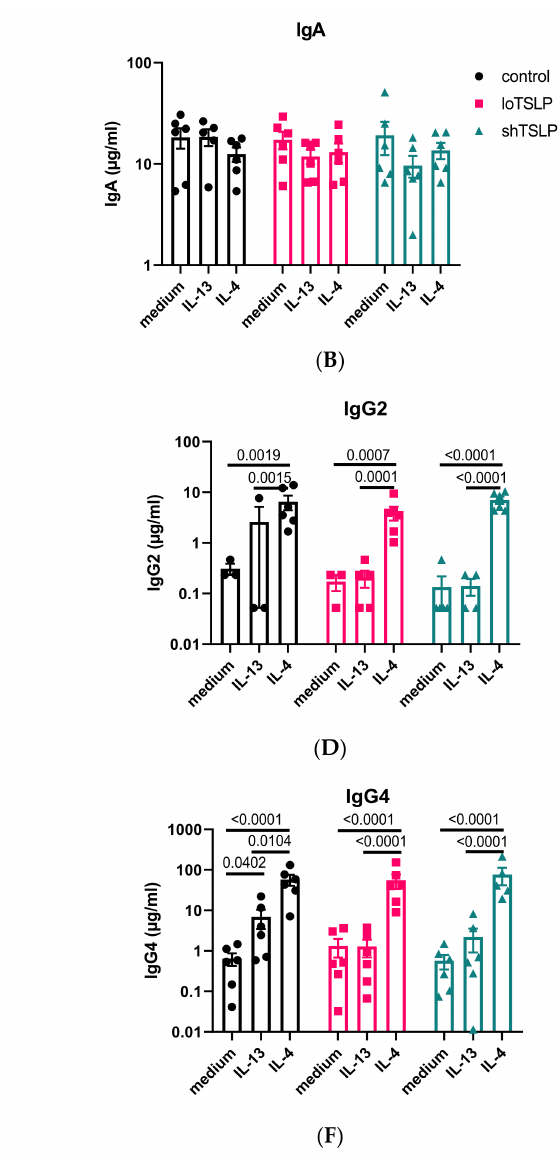
Figure 2. Regulation of Ig secretion by IL-4, IL-13, and TSLP. The concentrations of IgM ( A ), IgA ( B ), IgG1 ( C ), IgG2 ( D ), IgG3 ( E ), and IgG4 ( F ) in B cell culture supernatants after 11 days of stimulation using the T cell-dependent protocol using irradiated CD40L expressing cells. Mean concentrations and standard error of the mean are shown. Statistical test results are from ANOVA with Sidaks correction for multiple testing using log-transformed concentration data of four to six donors and two independent